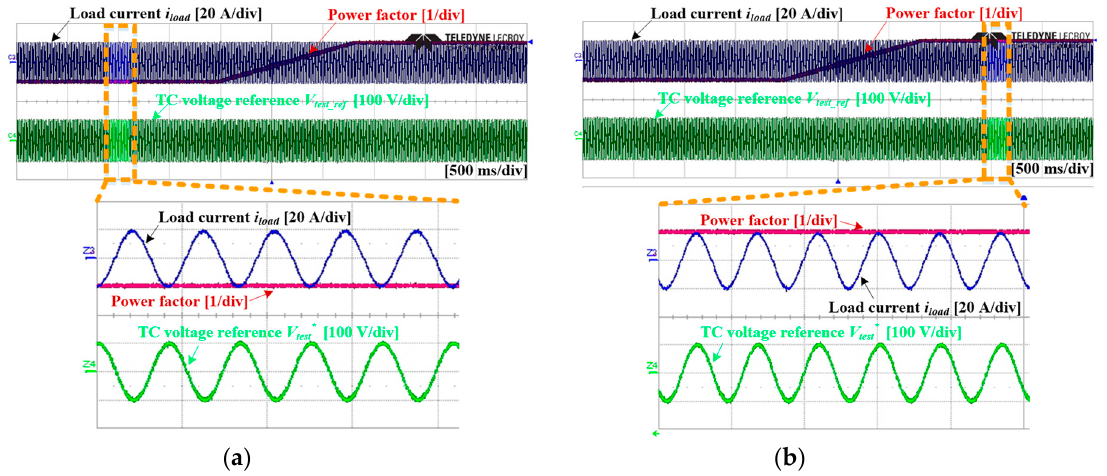
Figure 13. Experimental results for the power-factor control. ( a ) Power factor: − 1; ( b ) Power factor: 1.